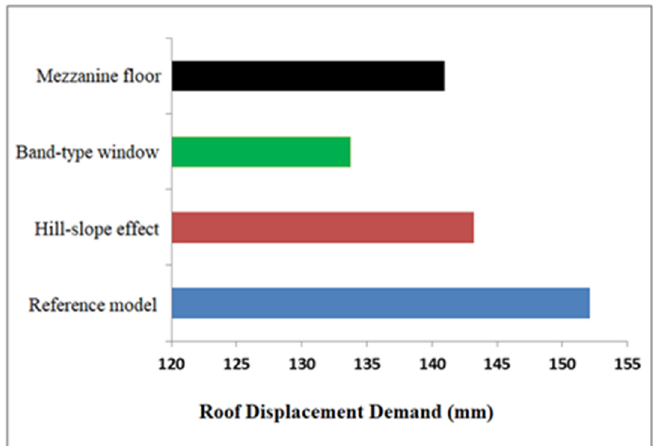
Figure 13. Comparison of roof displacement demands.